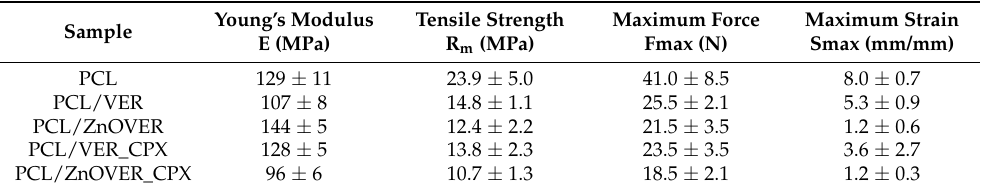
Table 4. The results of the static tensile tests with standard deviations (S.D.) of the pure PCL thin film and thin PCL/clay nanocomposite